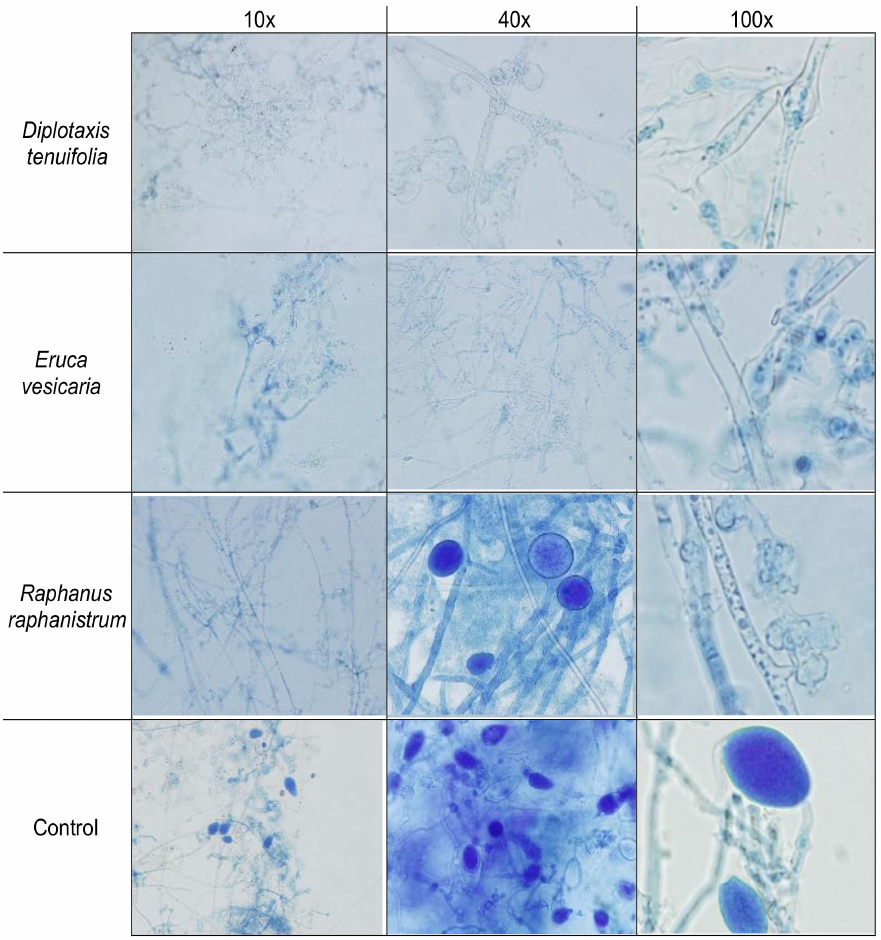
Figure 3. Mycelial growth and sporangia production. Although AREs (M2) of all species showed direct lysis of the sporangia and hyphae, the D. tenuifolia ARE showed the highest inhibition of P. cinnamomi activity (100% sporangia and chlamydospore inhibition, p <